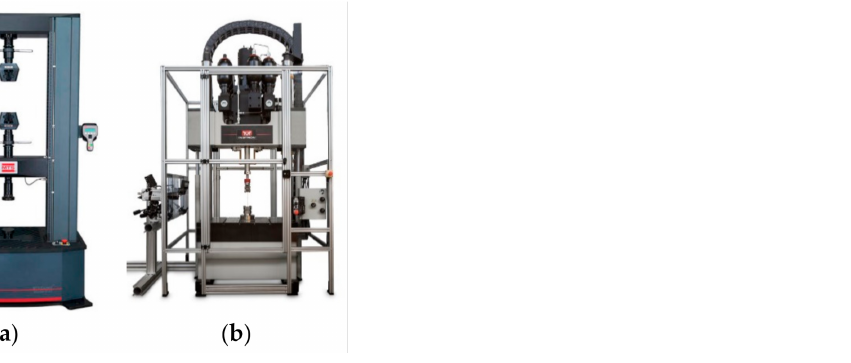
Figure 3. The quasi-static and dynamic compressive test machine: ( a ) MTS 810 testing machine; ( b ) Instron VHS high rate testing system machine.